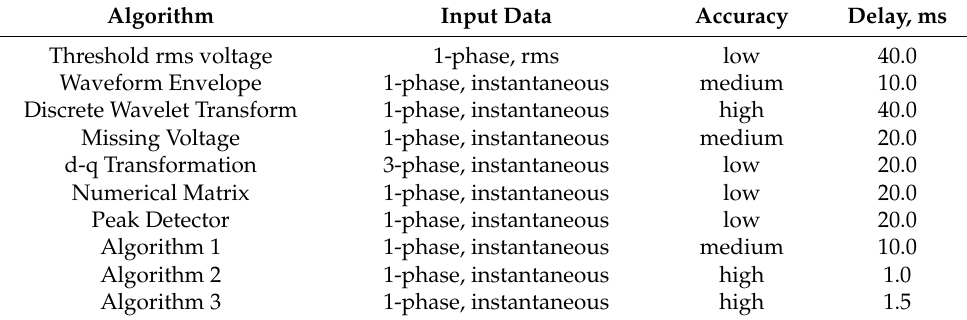
Table 6. Comparison of developed algorithms with existing